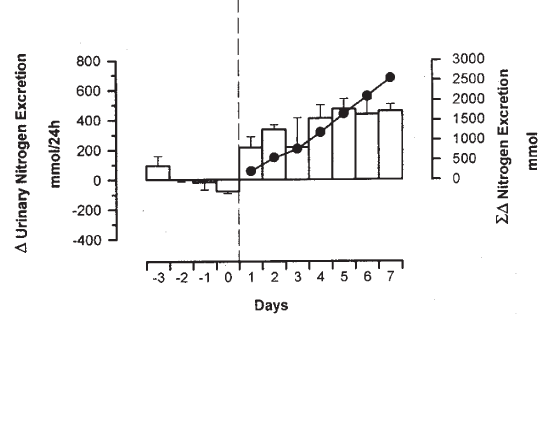
Effect of metabolic acidosis on nitrogen excretion. Subjects lost more than 2500 mmol of nitrogen over a period of one week. Induction of acidosis was per- formed by oral inges- tion of NH 4 Cl result- ing in steady-state bi- carbonate concentra- tions of around 15 mmol/l ([6], with per- mission, The Journal of Clinical Investiga-